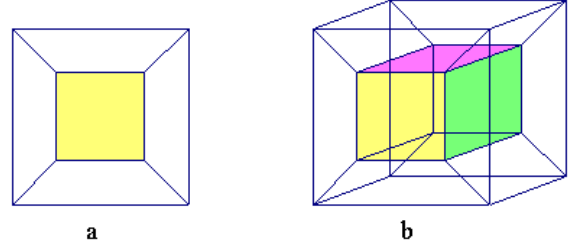
Figure 2: Generalising a cube to the fourth dimension In a similar way, by using analogy we can constructively define a generalisation of the concept of a parallelogram to hexagons by defining a parallelo-hexagon as a hexagon with opposite sides equal and parallel (see Figure 3). Or by relaxing one or the other condition, we can generalise even further by constructively defining a parallel-hexagon as a hexagon with opposite sides parallel or a oppo-sided hexagon as a hexagon with opposite sides equal.